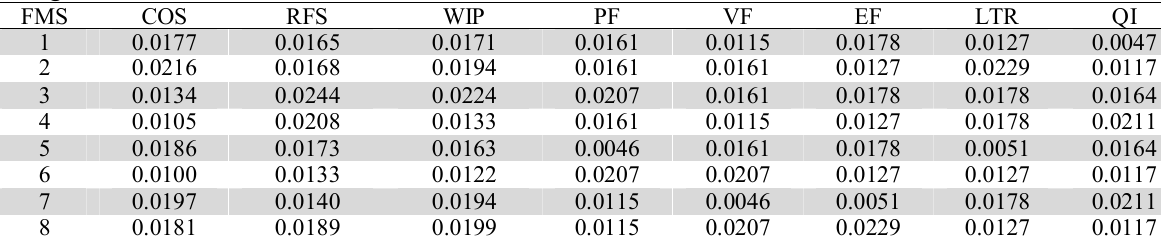
Weighted normalized decision matrix for ARAS method